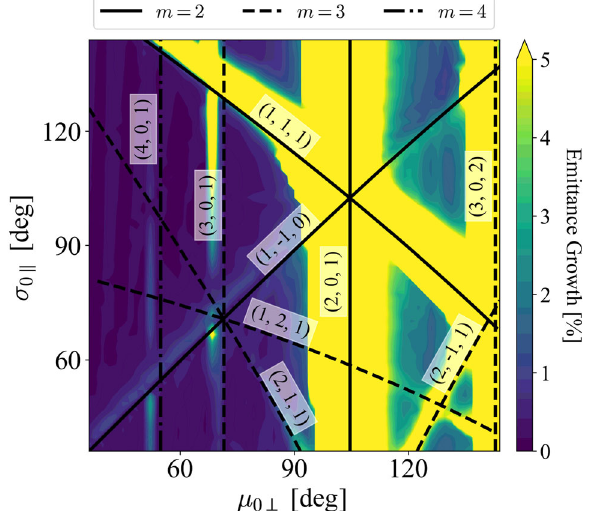
FIG. 4. W ARP simulation result obtained with the equiparti- tioned waterbag distribution. PIC simulations were done at 3721 ð¼ 61 × 61 Þ different operating points uniformly distributed in the range 36 ° < μ 0 ⊥ ; σ 0 k < 144 °, which enables us to identify instability bands wider than about 2°. The emittance-growth rates evaluated at the exit of the 100th AG cell are color-coded in the tune diagram. η ⊥ is adjusted to 0.8 over the whole tune space. The transverse emittances are also fixed at injection, while we choose the initial longitudinal emittance so as to meet the equipartition- ing condition. Black lines indicate the positions of low-order coherent resonances predicted by Eq. (6) with C 2 ¼ 0 . 7 , C 3 ¼ 0 . 8 , and C 4 ¼ 0 . 9 . Three numbers beside each line re- present ð n ⊥ ; n k ; n 0 Þ